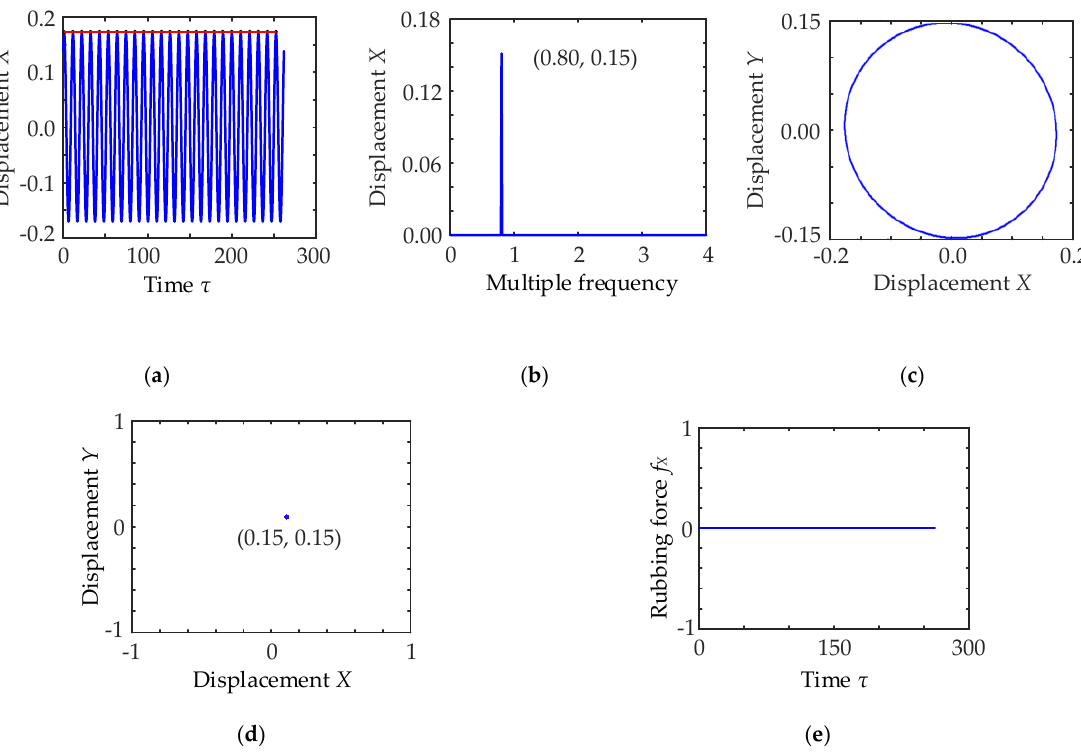
Figure 9. Rotor displacement when n = 5.5 krpm. ( a ) x - t ; ( b ) Amplitude spectrum; ( c ) Rotor trajectory; ( d ) Poincare mapping; ( e ) Rubbing force.